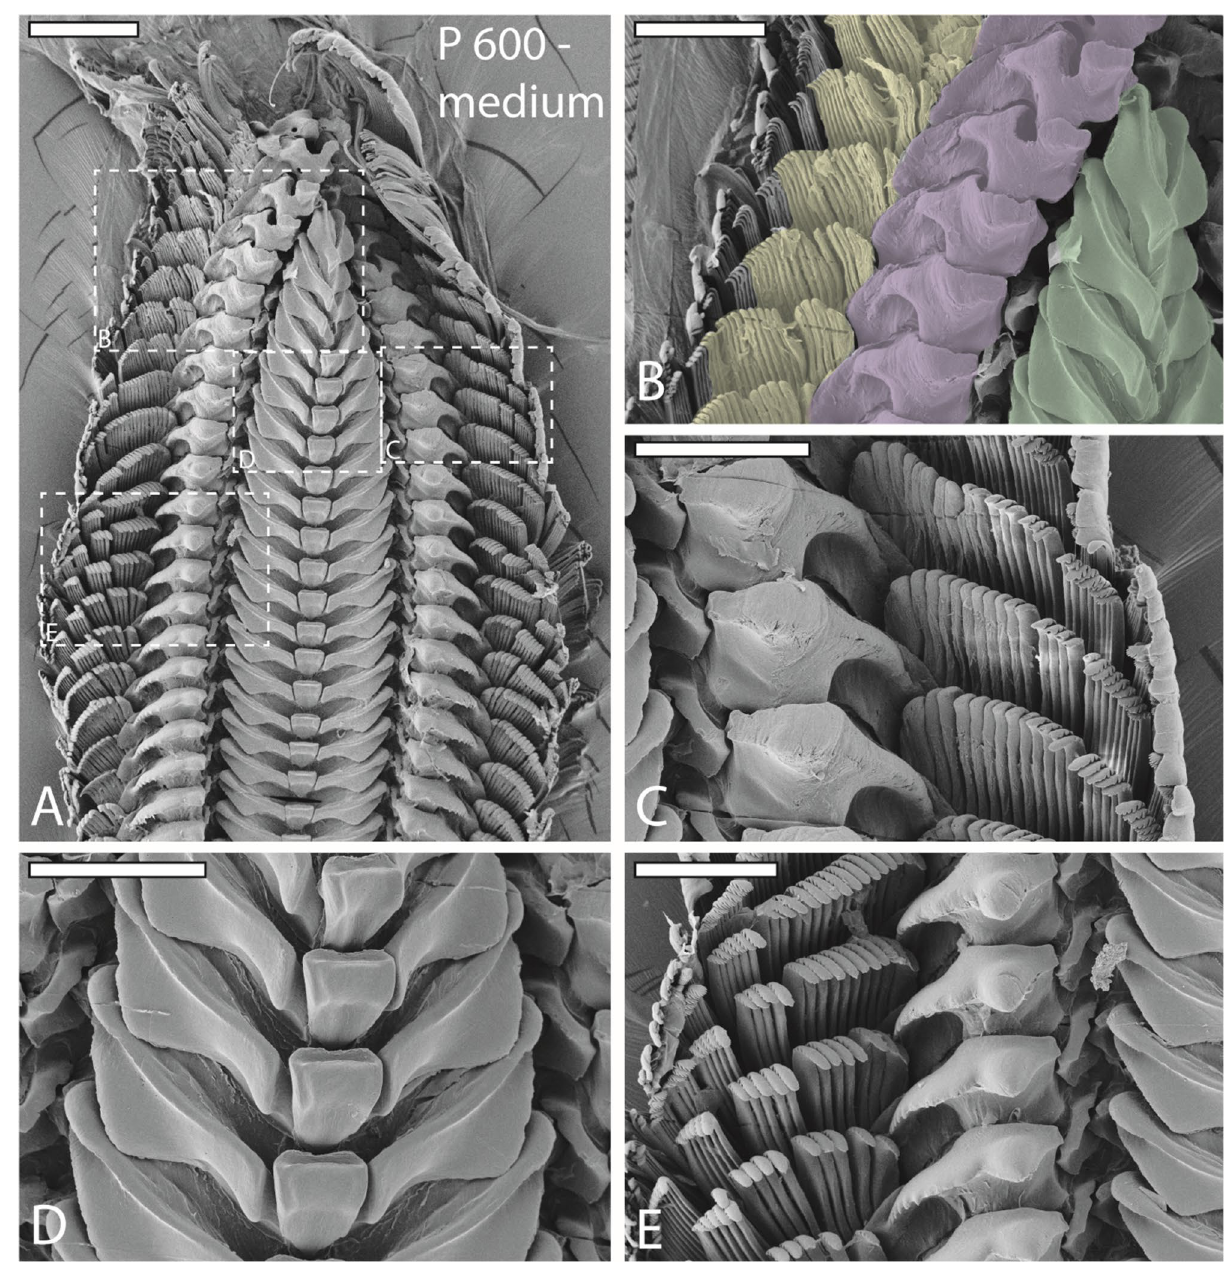
Figure 4. SEM images of one radula from specimen sheltered on medium sandpaper (P 600). ( A ) Image of outermost part of radula (wear and digestive zone). ( B – E ) Magnifications of same region as in ( A ). ( B ) Right wear zone with colored outlines of lateral teeth I (green), lateral teeth II (purple), and inner 15 marginal teeth (yellow; only marginal teeth that show signs of wear were colored). ( C ) Left wear zone. ( D ) Worn lateral teeth I and unworn central teeth. ( E ) First signs of wear on lateral teeth I, lateral teeth II, and marginal teeth. Scale bars: A = 200 μm, B–E = 100